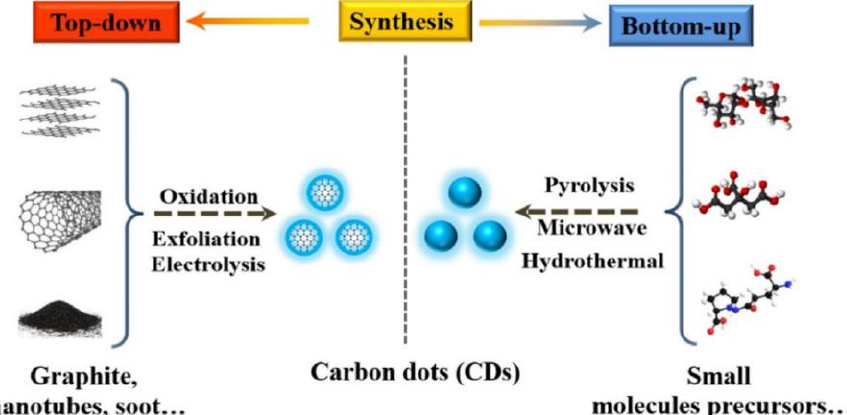
Figure 2. Top-down and bottom-up synthetic pathways for CDs. Reproduced with authorization from [23] .